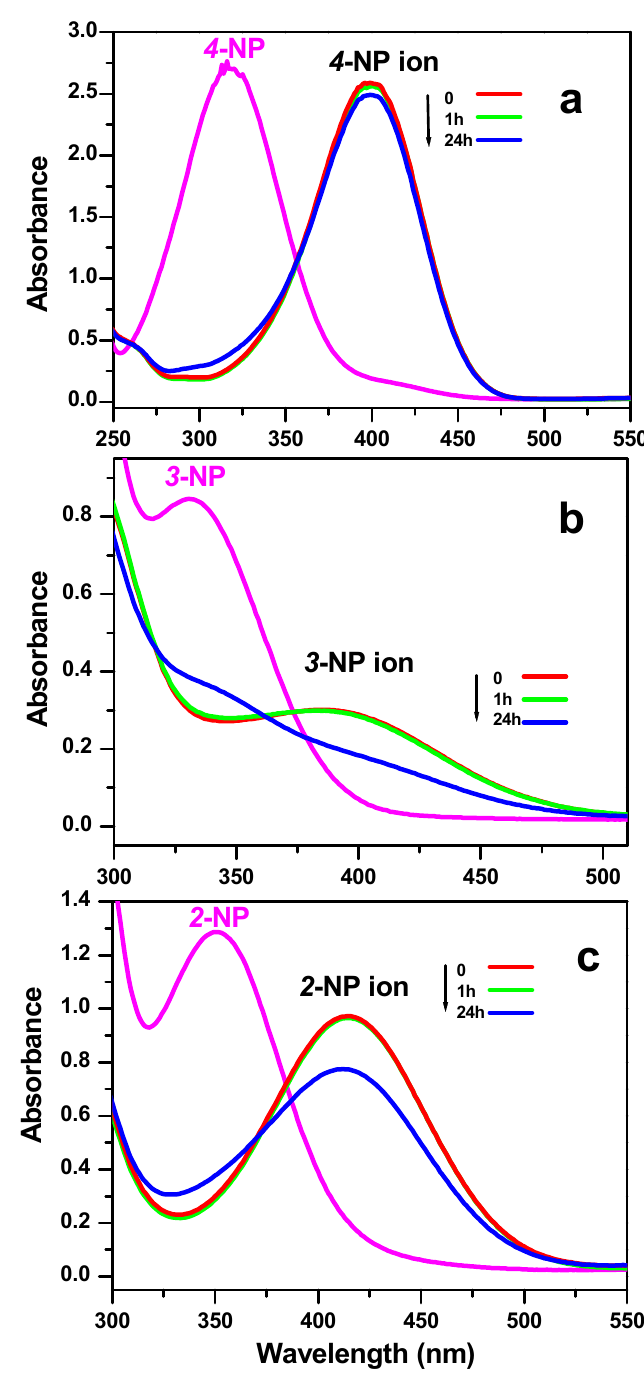
Figure 7. UV–vis spectra of: ( a ) 4-nitrophenol; ( b ) 3-nitrophenol; and ( c ) 2-nitrophenol (NP) isomers before and after adding NaBH 4 without adding nanoparticles at room temperature.